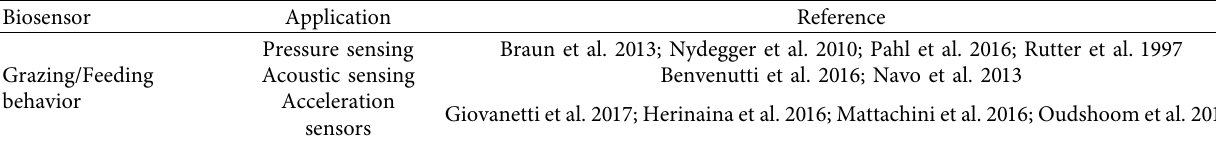
Table 1: Application of the sensor on grazing and behavior of